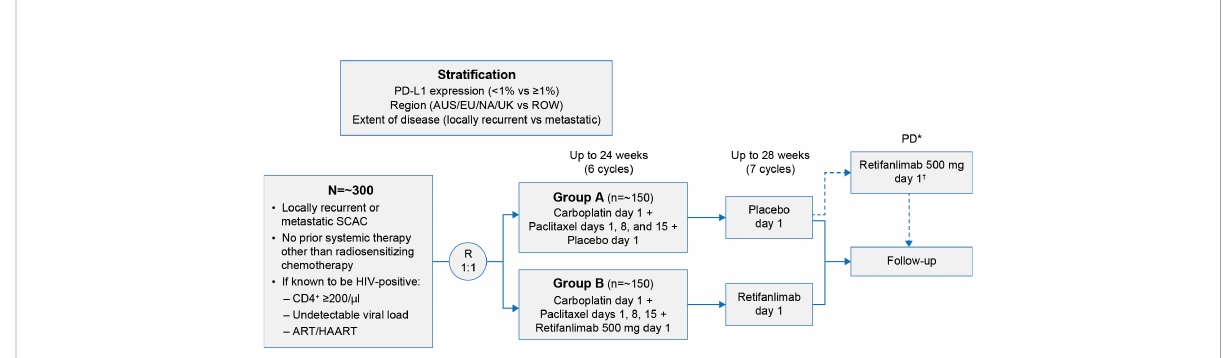
FIGURE 1 POD1UM-303/InterAACT 2 study design. *Veri fi ed by BICR. † Optional crossover period for quali fi ed patients. ART/HAART, antiretroviral therapy/ highly active antiretroviral therapy; AUS, Australia; BICR, blinded independent central radiographic review; EU, European Union; HIV, human immunode fi ciency virus; NA, North America; PD, progressive disease; PD-L1, programmed cell death ligand 1; R, randomization; ROW, rest of the world; SCAC, squamous carcinoma of the anal canal; UK, United